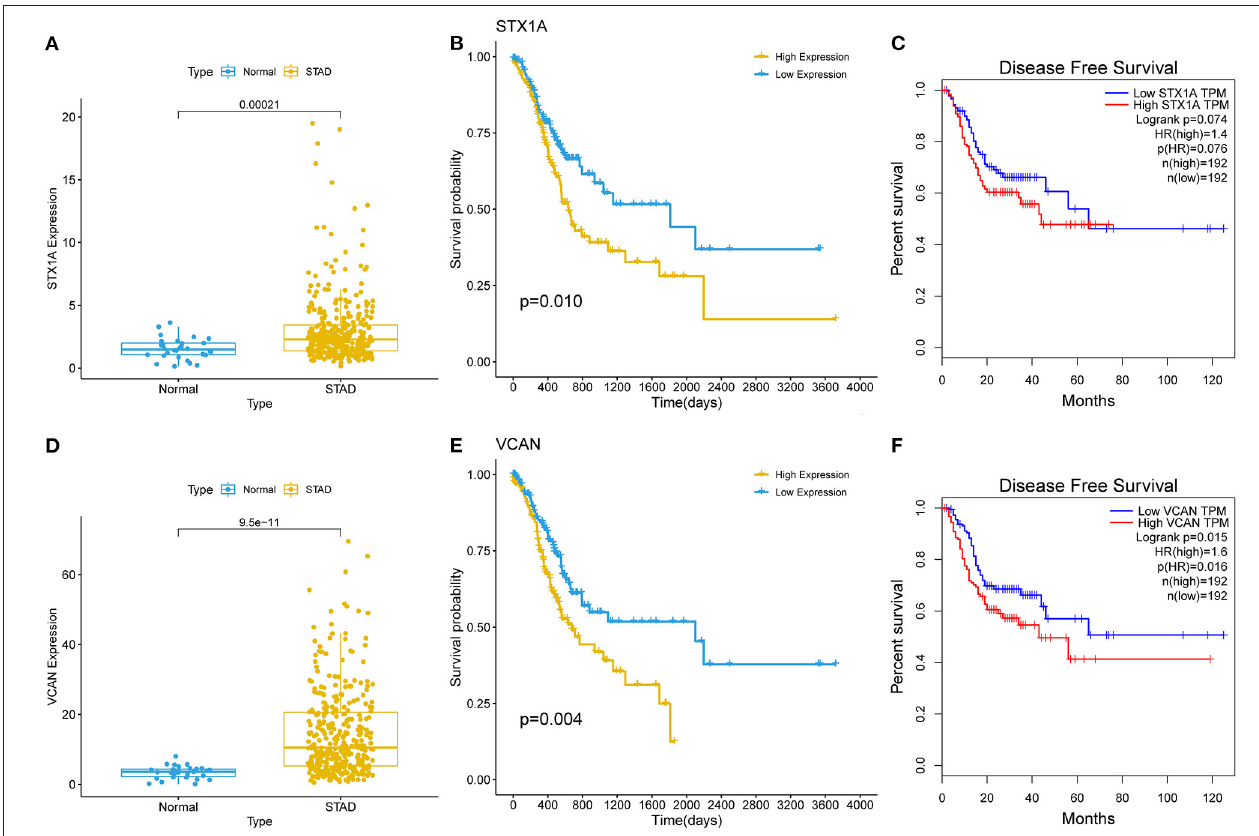
FIGURE 4 | The survival analyses of two target genes (VCAN and STX1A). (A) Kalpan–Meier (K–M) plot of STX1A. (B) Expression of STX1A between gastric cancer (GC) and normal tissues. (C) Disease-free survival of STX1A. (E) K–M plot of VCAN. (D) Expression of VCAN between the GC and normal tissues. (F) Disease-free survival of VCAN. The relationship between a gene and survival was analyzed through the K–M curve which was evaluated by log-rank